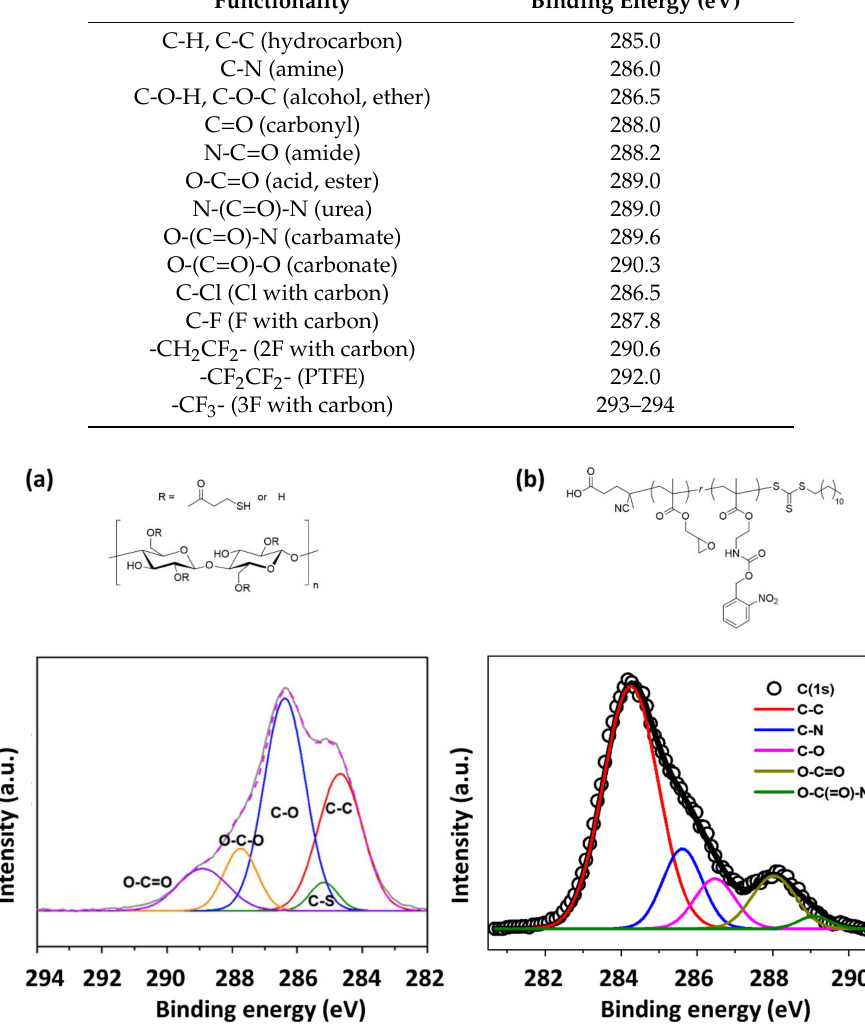
Table 1. Representative XPS C(1s) binding energy of di ff erent functional groups.